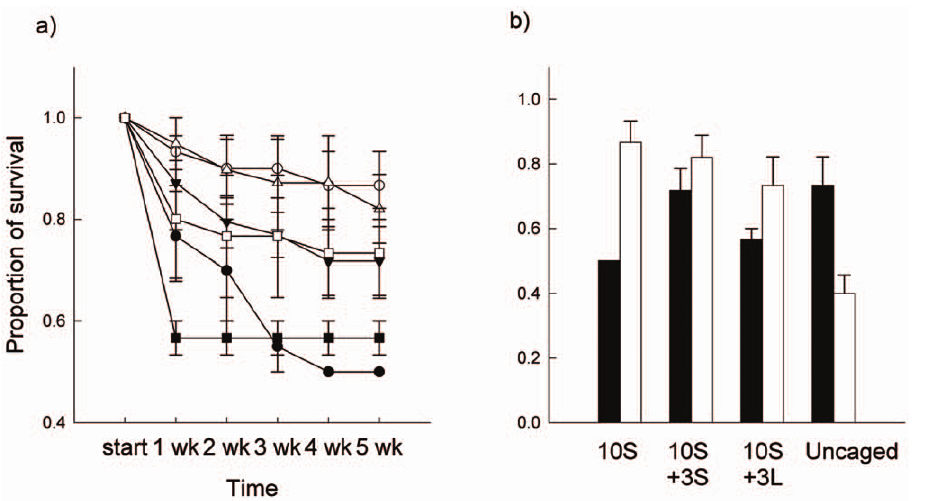
Figure 1. Survival of small limpets. Mean ( 6 SE; n =3) proportion of survival of small P. vulgata for each week (wk; a) or at the end of the experiment (b). Treatments are: 10S (circles), 10S + 3S (triangles), 10S + 3L (squares). S, small limpets; L, large limpets. Black symbols and bars, without macroalgae; white symbols and bars, with macroalgae.